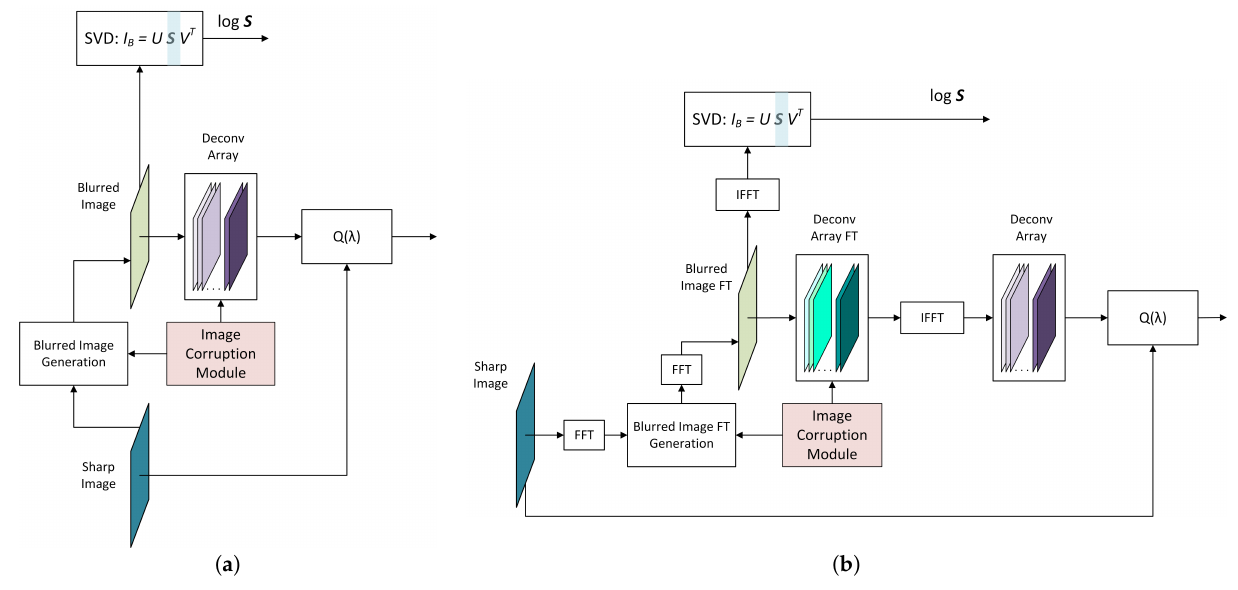
Figure 7. RegParamNet training data generation: ( a ) Tikhonov deconvolution; ( b ) Wiener deconvolution. RegParamNet